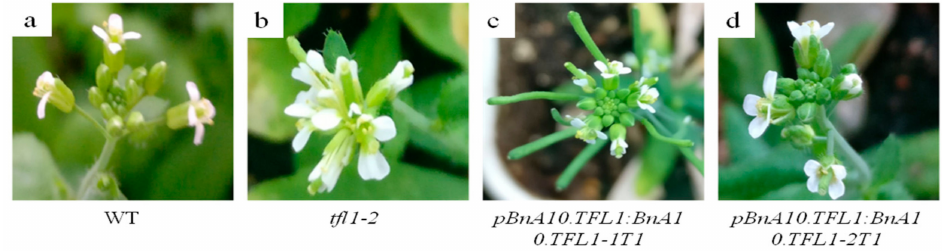
Figure 4. Architecture of terminal racemes in transgenic A. thaliana . ( a ) Wild-type A. thaliana (WT) shows an indeterminate phenotype. ( b ) The tfl1-2 mutant has a determinate phenotype with terminal flowers. ( c ) T1 A. thaliana transgenic plants transformed with pBnA10.TFL1:BnA10.TFL1-1T1 returned to an indeterminate phenotype. ( d ) T1 A. thaliana transgenic plants transformed with pBnA10.TFL1:BnA10. TFL1-2T1 also became indeterminate.